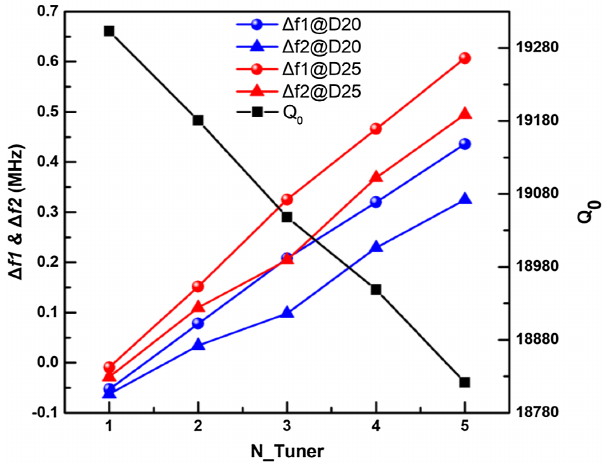
FIG. 13. Field flatness before and after tuning.